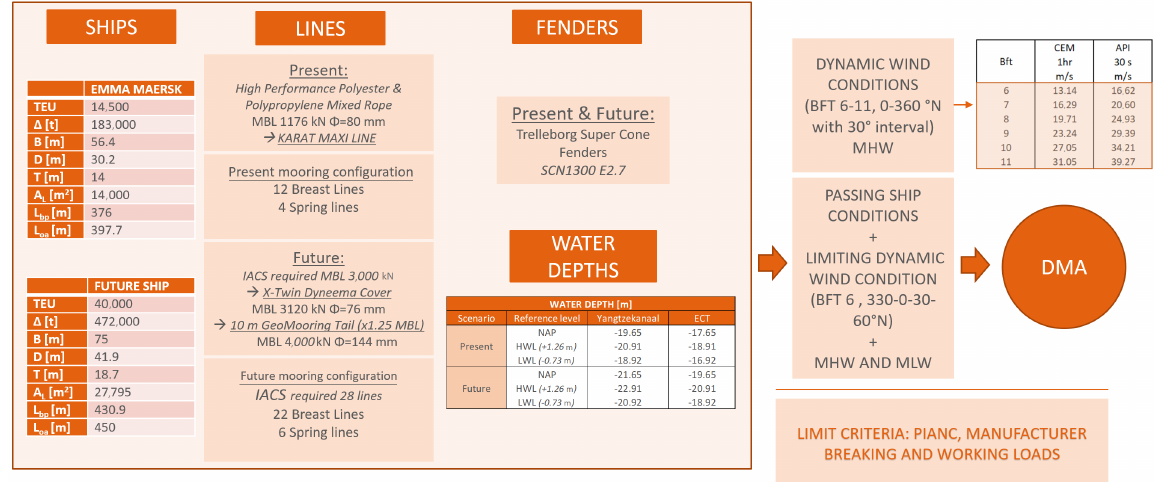
Figure 5. Selection of parameters for the Dynamic Mooring